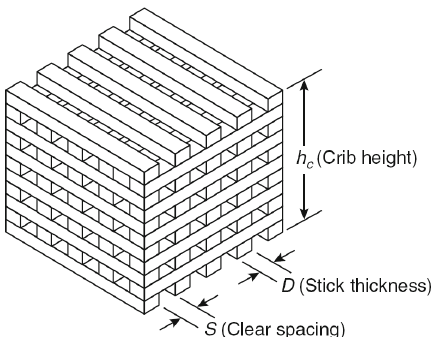
Figure B1. The general arrangement of a wood crib (Babrauskas,